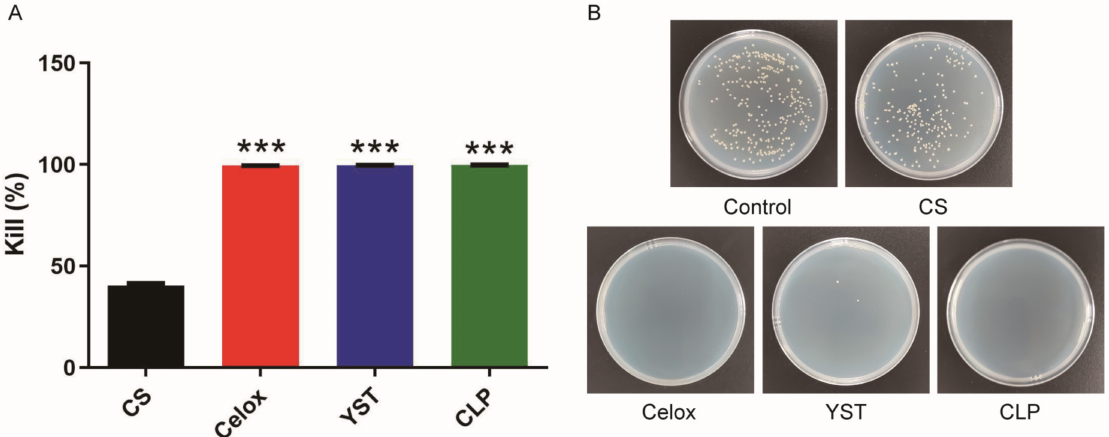
Figure 2. Antibacterial activity of hemostatic particles. ( A ) Antibacterial efficiency of hemostatic pacticles ( n = 4). ( B ) Photographs of S. aureus formed with hemostatic particles. Values represent means ± SEM. The differences between each group were performed using two-tailed unpaired t -test. The ‘NS’ indicated no significant difference, *** p <